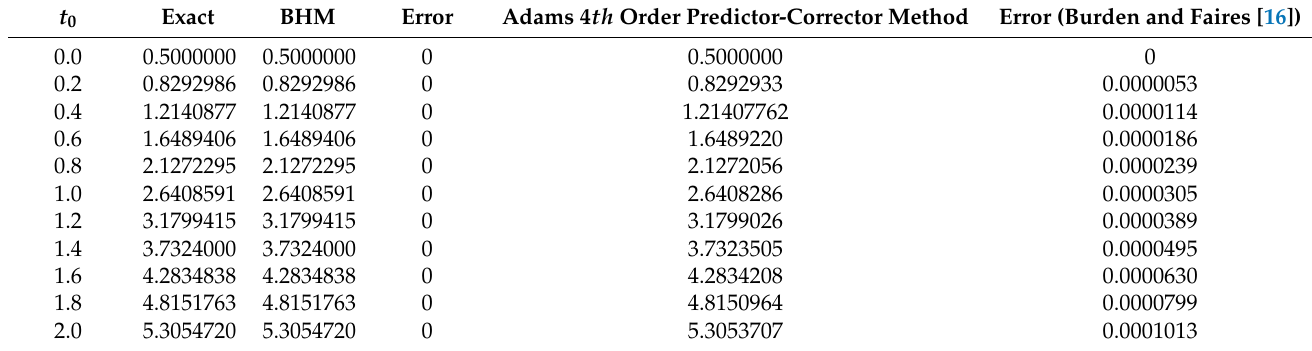
Table 2. Comparisons of errors of the results generated by the BHM and those obtained by Burden and Faires